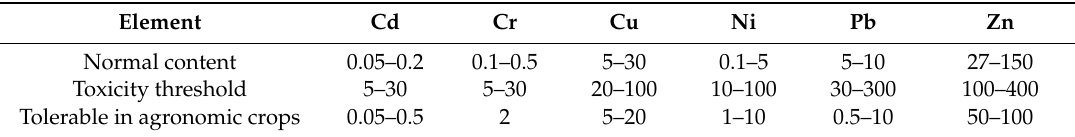
Table 6. The normal content and toxicity threshold values of the chosen elements in plants, in mg · kg − 1